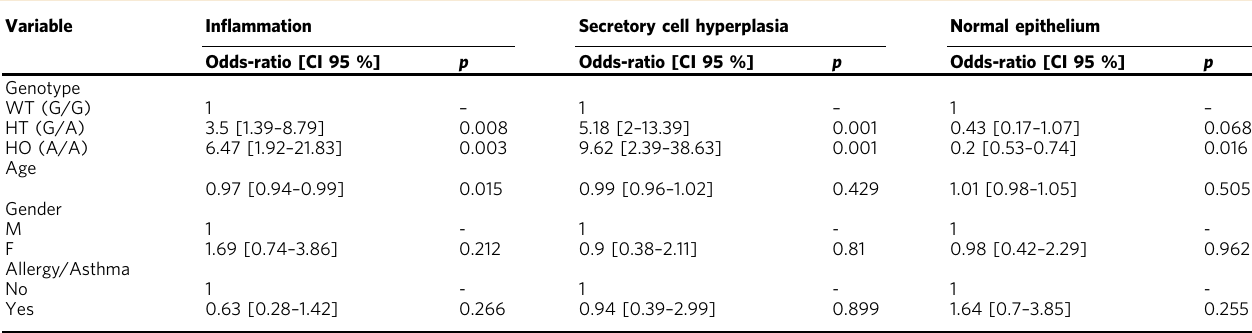
Table 1 Multivariate regression analysis of the effect of patients ’ genotype and age/gender/allergy-asthma on epithelium remodeling.